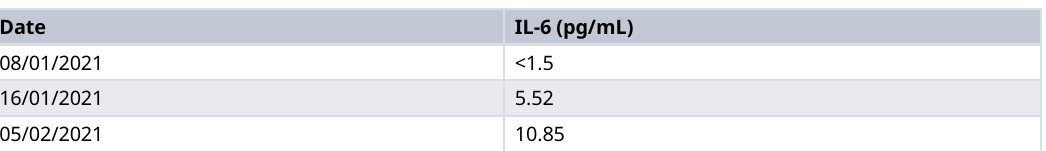
Table 2. IL-6 results for the patient over four weeks.